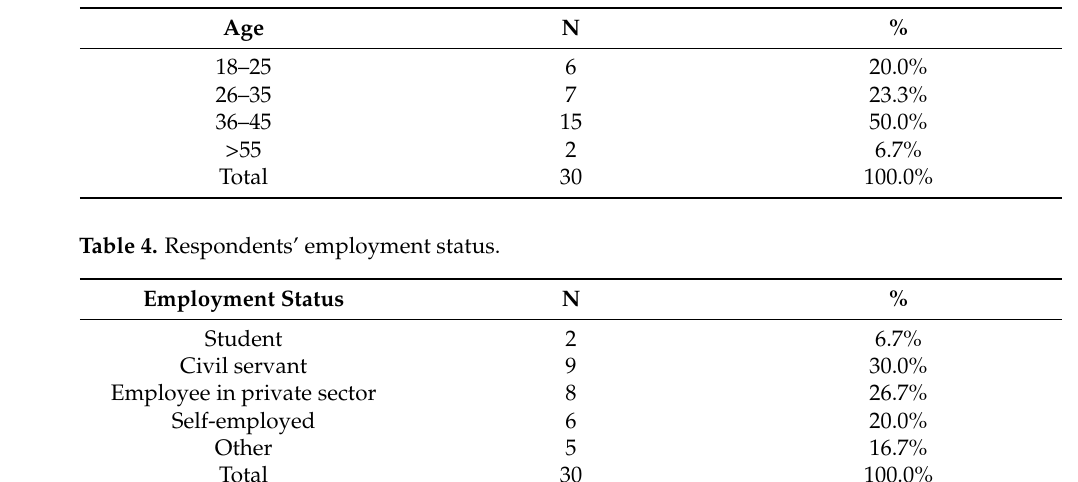
Table 3. Respondents’ age category.